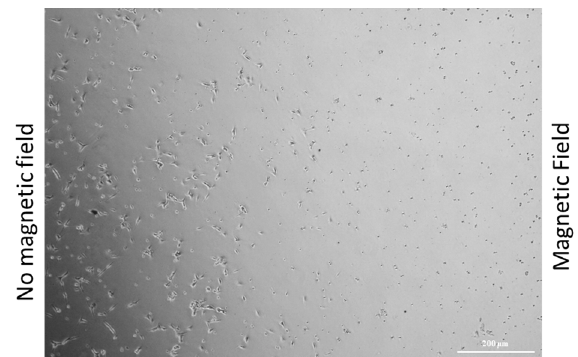
Figure 9. Optical microscope image U87 cells incubated with 10 µM CisPt loaded γ -Fe 2 O 3 @NGO under the effect of a permanent magnet.